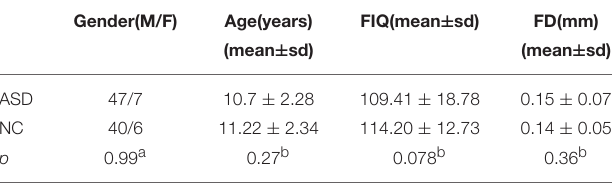
TABLE 1 | The demographic information for ASD group and NC group.